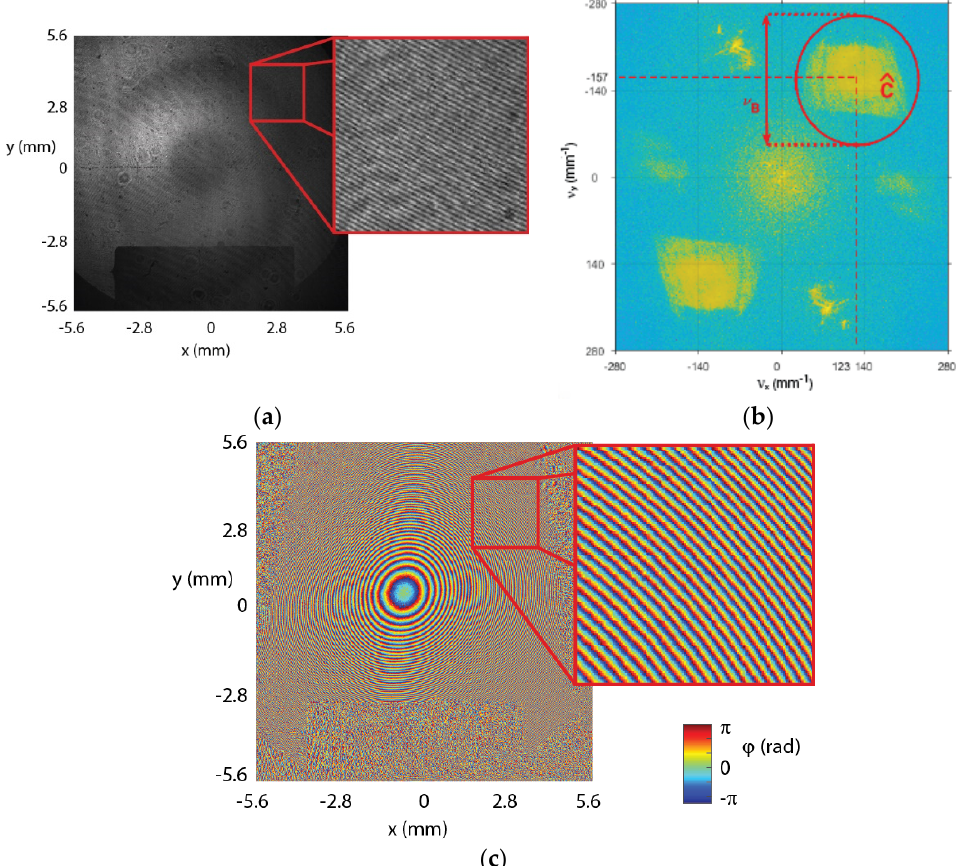
Figure 3. ( a ) Interferogram at t = 0 s (reference state), ( b ) magnitude in logarithmic scale of the in−ter- ferogram’s FT spectra with the denoted term (cid:1829)(cid:4632)((cid:2029) (cid:3051) , (cid:2029) (cid:3052) ) , ( c ) the wrapped phase computed from (cid:1829)(cid:4632)((cid:2029) (cid:3051) , (cid:2029) (cid:3052) )